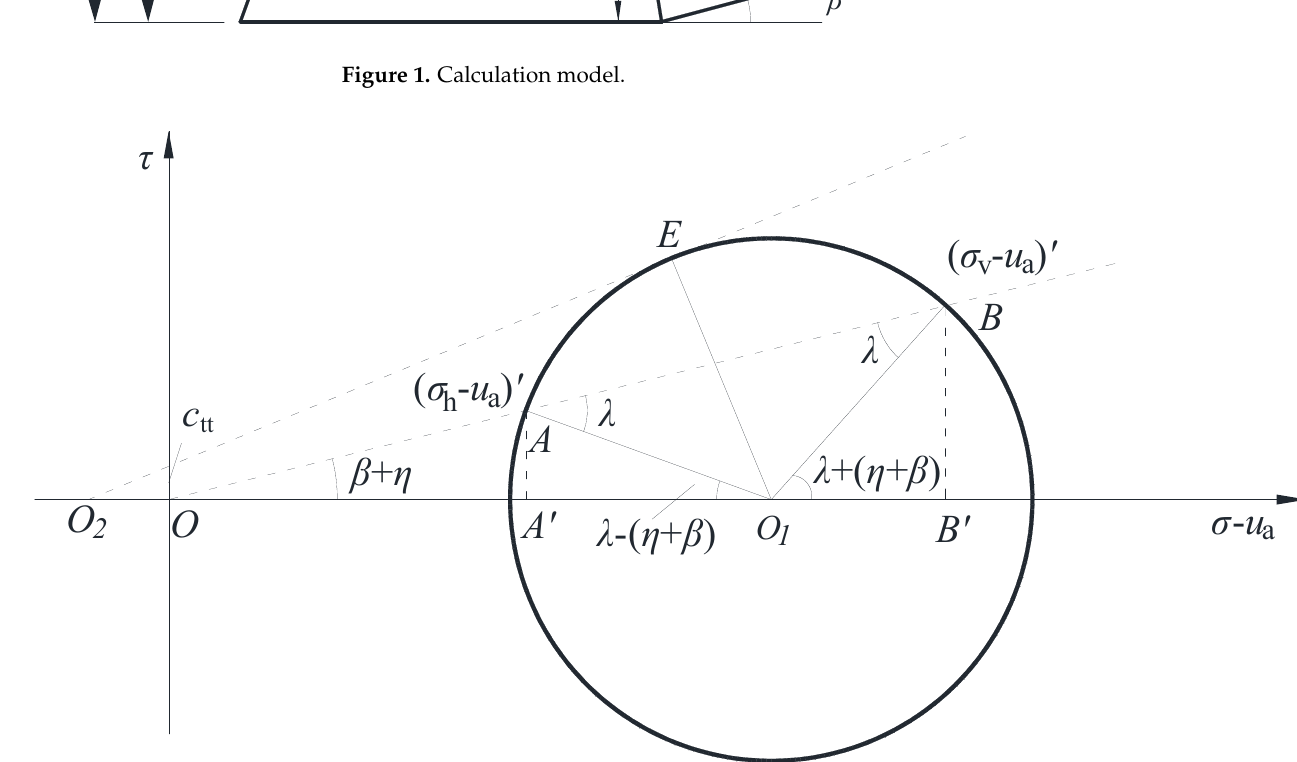
Figure 1. Calculation model.